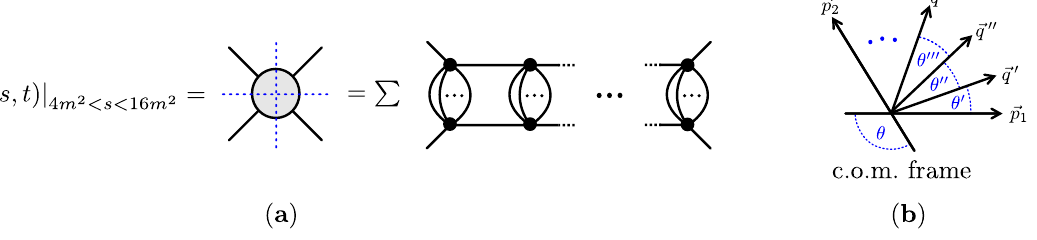
Figure 6 . (a) The Landau diagrams that contribute to the double spectral density in the elastic strip 4 m 2 < s < 16 m 2 and 4 m 2 < t . In this kinematical regime there can be only two particles in the s -channel. Hence, the corresponding Landau diagrams have a simple structure of iterative two-particle exchange in the s -channel and in between, any number of particles exchange in the t -channel. (b) Analogously to figure 1, the corresponding Landau curves originate from a simple geometric constraint on physical kinematics, see discussion after